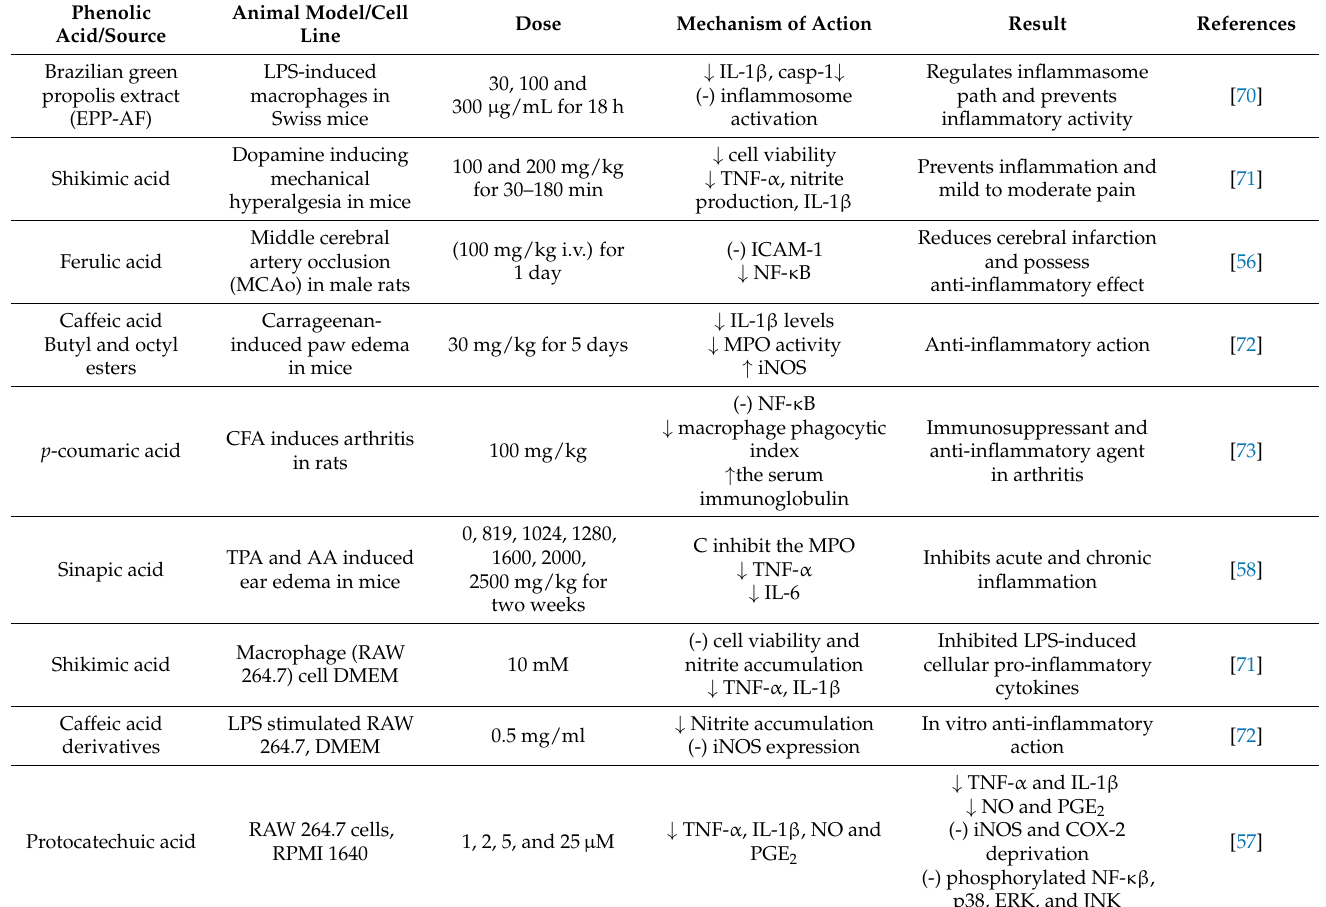
Table 3. Anti-inflammatory and analgesic actions of phenolic